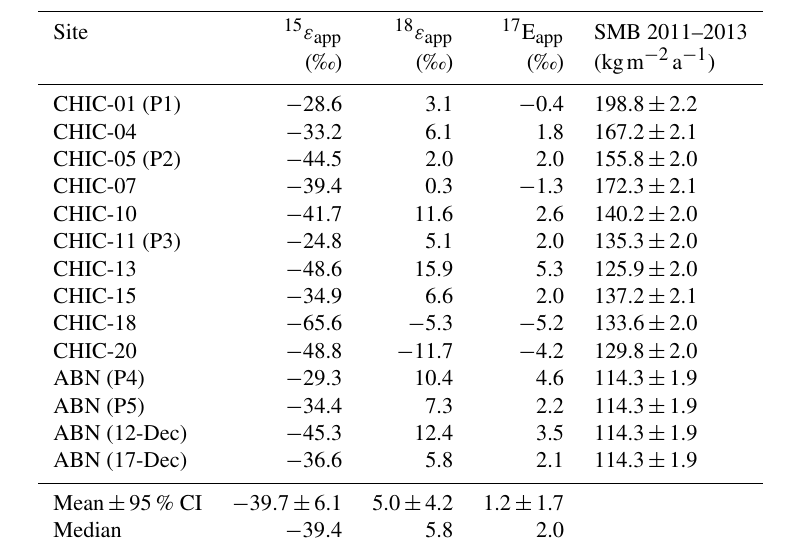
− isotopic fractionation constants for sites along the CHICTABA traverse. Values for δ 15 N NO Table 3. Apparent NO 3 ( 18 ε app ), and (cid:49) 17 O NO ( 17 E app ) were calculated from the paired skin layer and 1m depth samples at individual sites. The MAR-estimated 3 surface mass balance (SMB) (Agosta et al., 2019; Amory et al., 2021) is provided for each site for reference, and further site information is given in Table 1. For the five pit samples (P1–P5), a pseudo-depth layer sample was calculated by weight-averaging samples representing at least one full annual cycle and paired with a skin layer sample taken from the same site. Note that the site ABN was sampled four separate times within a 5d period.